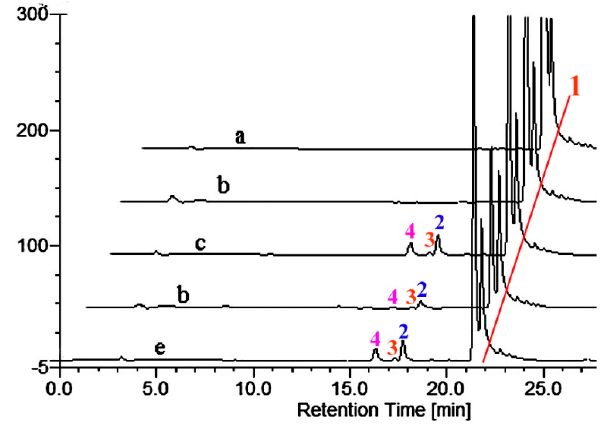
Figure 8. ( a ) HPLC chromatogram of progesterone; ( b )–( e ) progesterone incubations with empty vector, M01A82W, M01A82WS72I and M11A82W, respectively. Peak 1 is a progesterone standard; peaks 2, 3 and 4 are three monohydroxylated metabolites of progesterone.